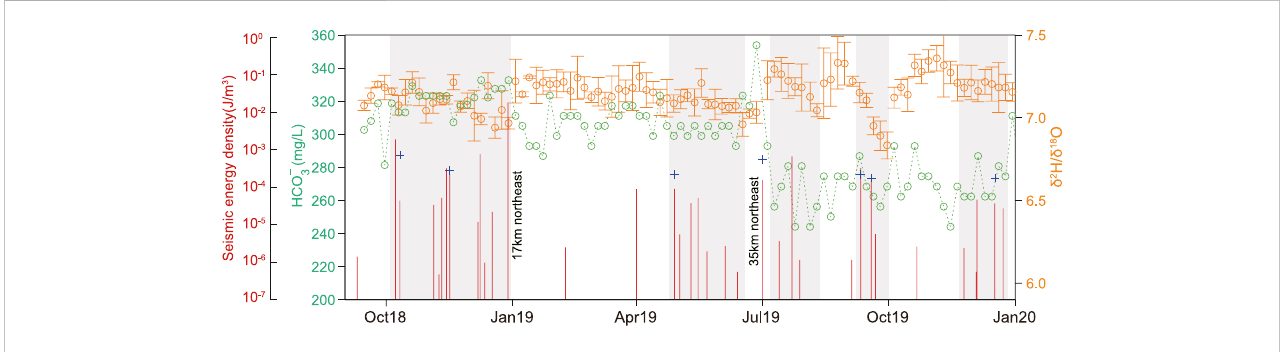
FIGURE 7 Comparison of hydrogen and oxygen isotope ratios, HCO 3 − concentration, and seismic activity during the study period. The red vertical line represents the cumulative seismic energy density, and the yellow and green circles indicate the hydrogen and oxygen isotope ratio and the HCO 3 − concentration,